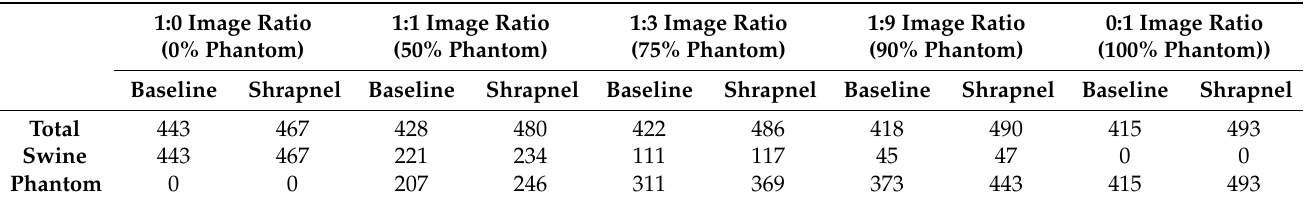
Table 2. Total number of swine and phantom images for each training set used in this study. Five swine: phantom ratios are shown: 1:0, 1:1, 1:3, 1:9, 0:1.